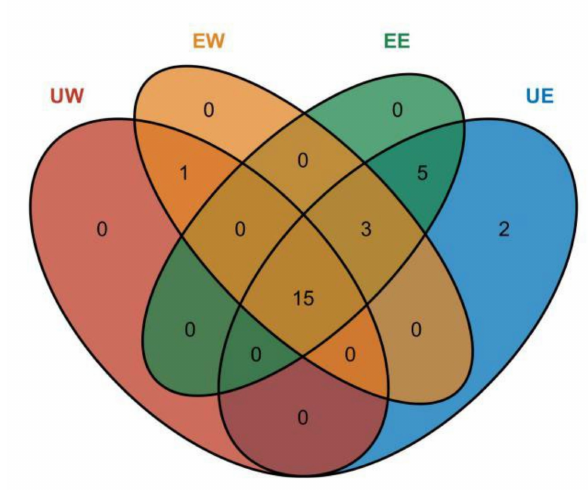
Figure 3. Venn diagram of phenolic compounds identified in the four